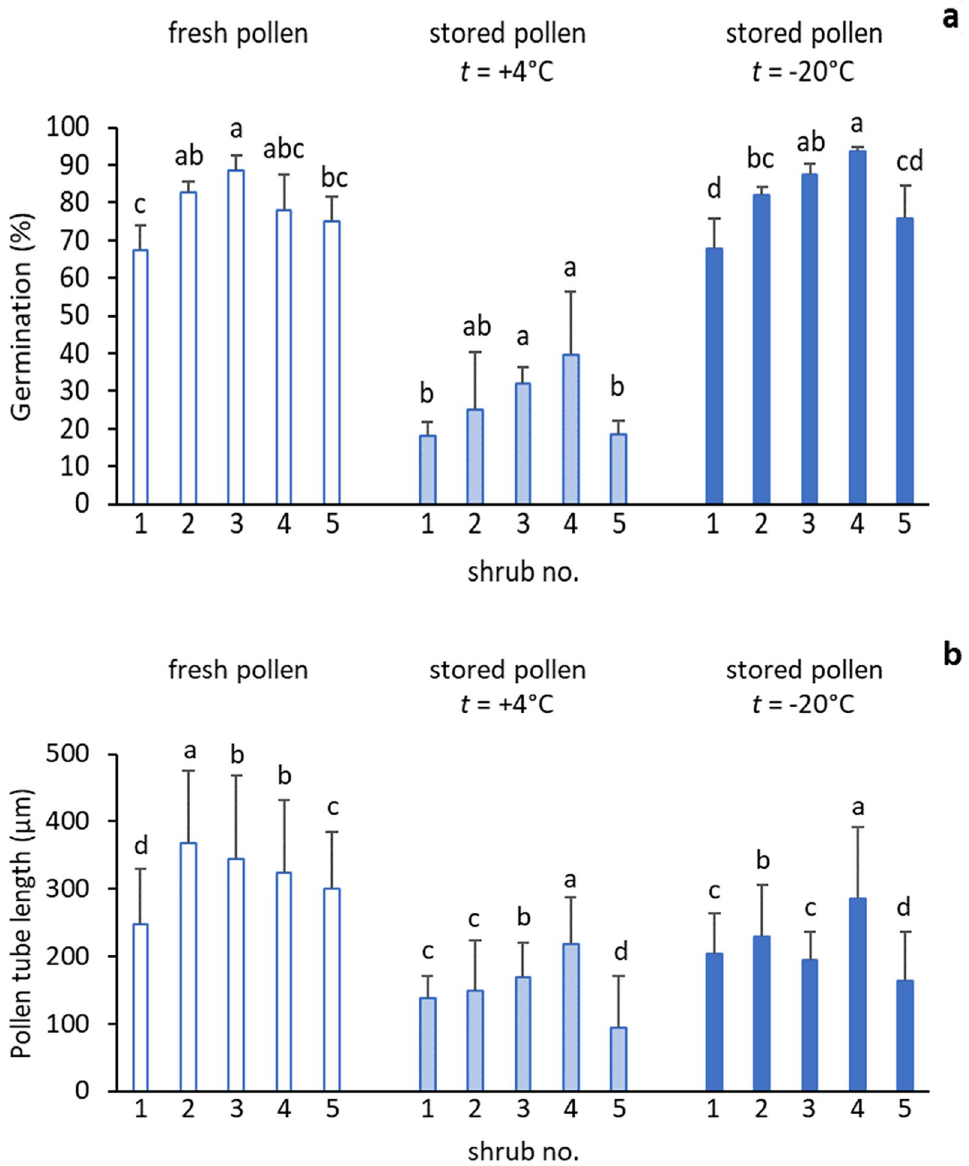
Figure 1. Graphical illustrations of variation in pollen germination percentage ( a ) and pollen tube length ( b ) of individual shrubs revealed in fresh pollen and in pollen under storage. Different letters refer to the statistical significance of the differences between tested individuals and storage variants, resulting from Duncan’s pairwise